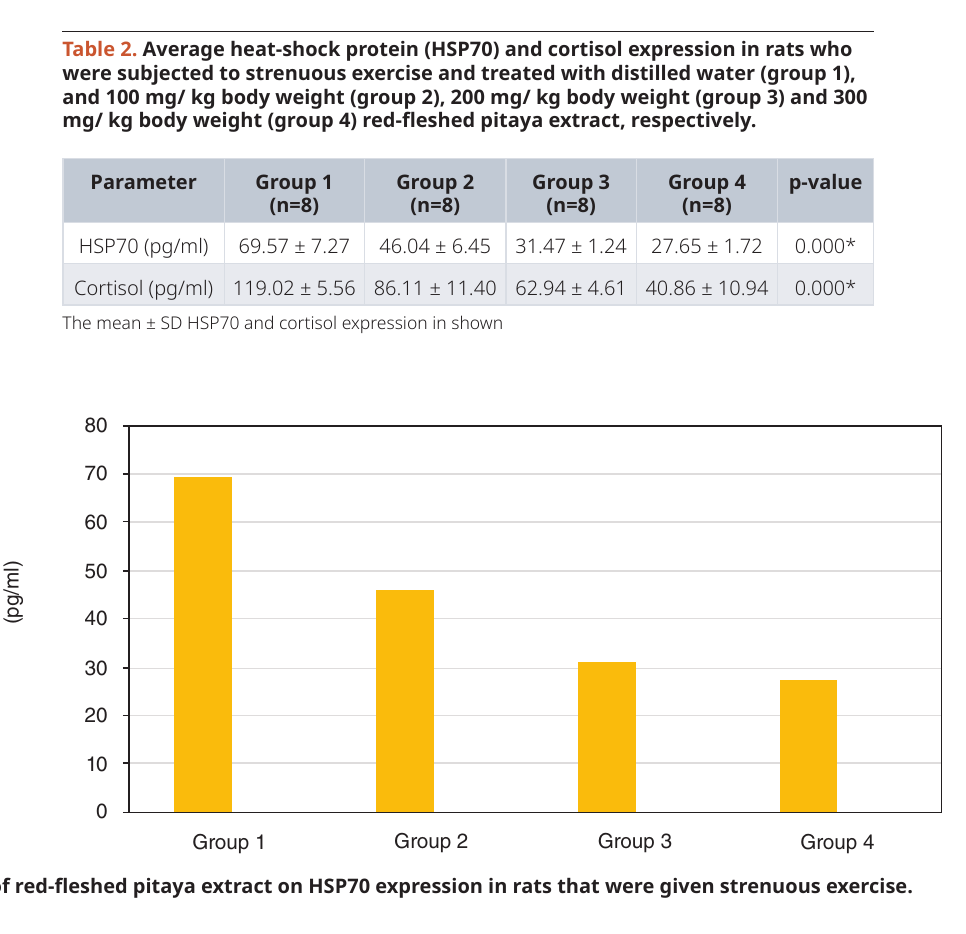
reducing HSP70 expression compared to group 1 and 2, with no big variance from group 3.